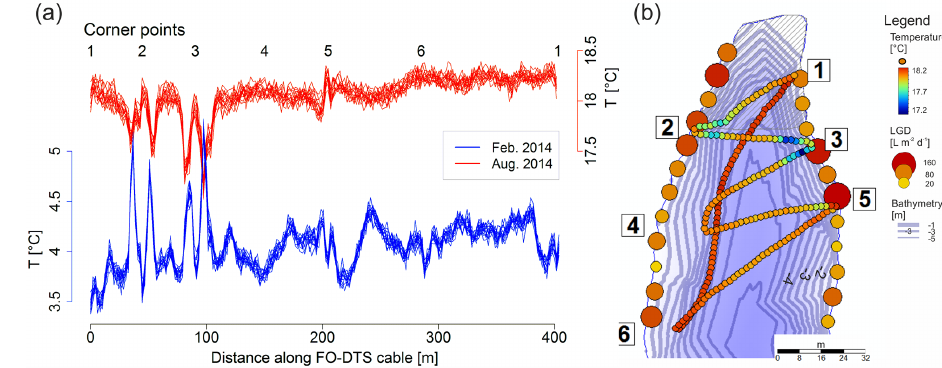
Figure 6. Lake sediment temperatures measured with the FO-DTS system. (a) Temperatures measured in February and August along the FO-DTS cable. (b) Sediment temperatures measured with the FO-DTS in August 2014 (median); LGD rates along the shoreline were derived from VTPs measured in June 2012.